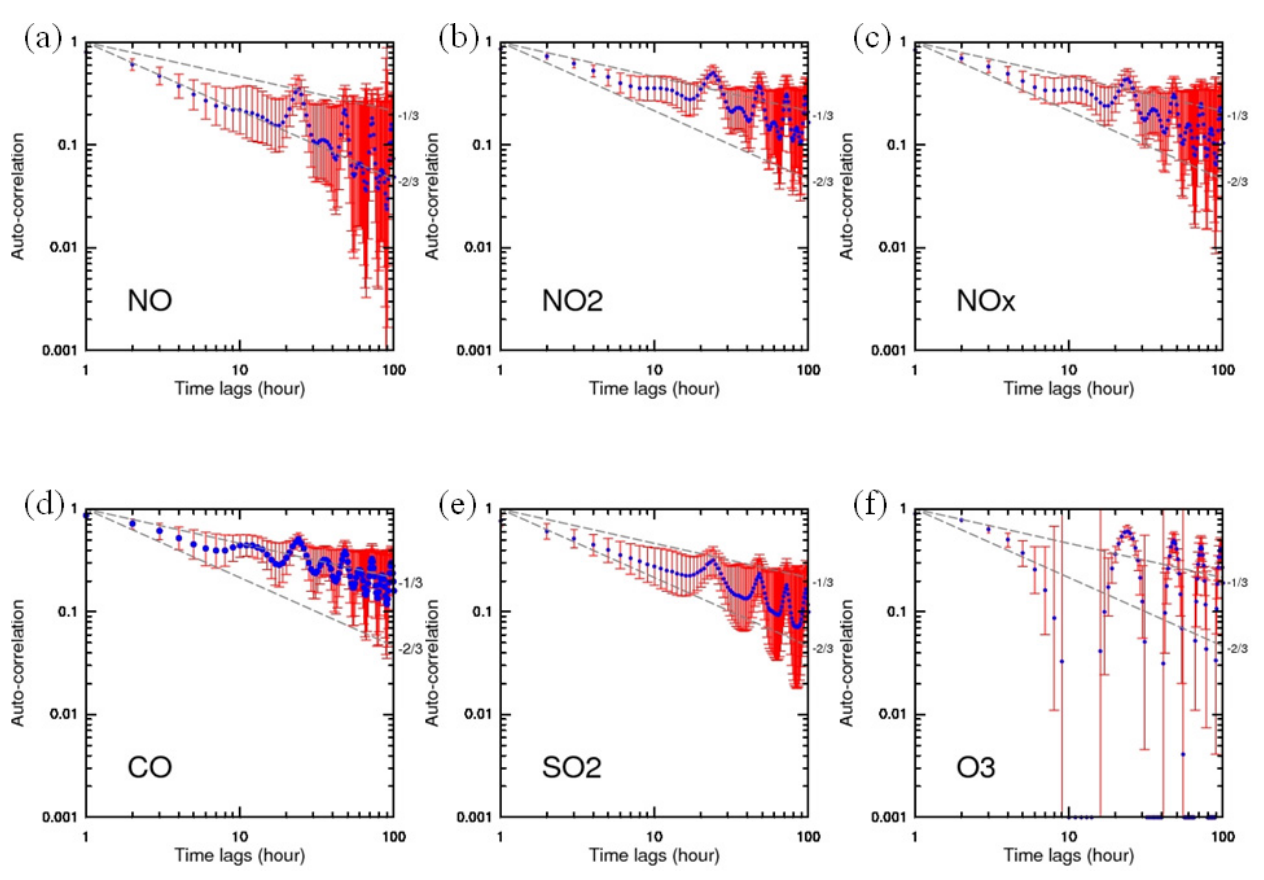
Fig. 2. The auto-correlations (in log-log scale) of the gases, NO (panel a ), NO 2 (panel b ), NO x (panel c ), CO (panel d ), SO 2 (panel e ), and O 3 (panel f ). The blue dots are the 74-station averages, and the red bars are standard deviations from the averages. The grey dash lines indicate the power-law scaling of − 1/3 and −